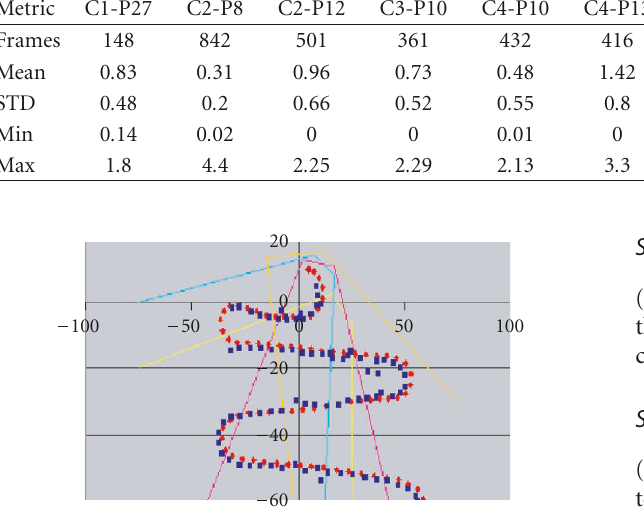
Figure 17: Vehicle 2D trajectory graph showing (red) the EGNOS trajectory and (blue) the estimated location on the apron. The scale is measured in metres and the camera fields of view are